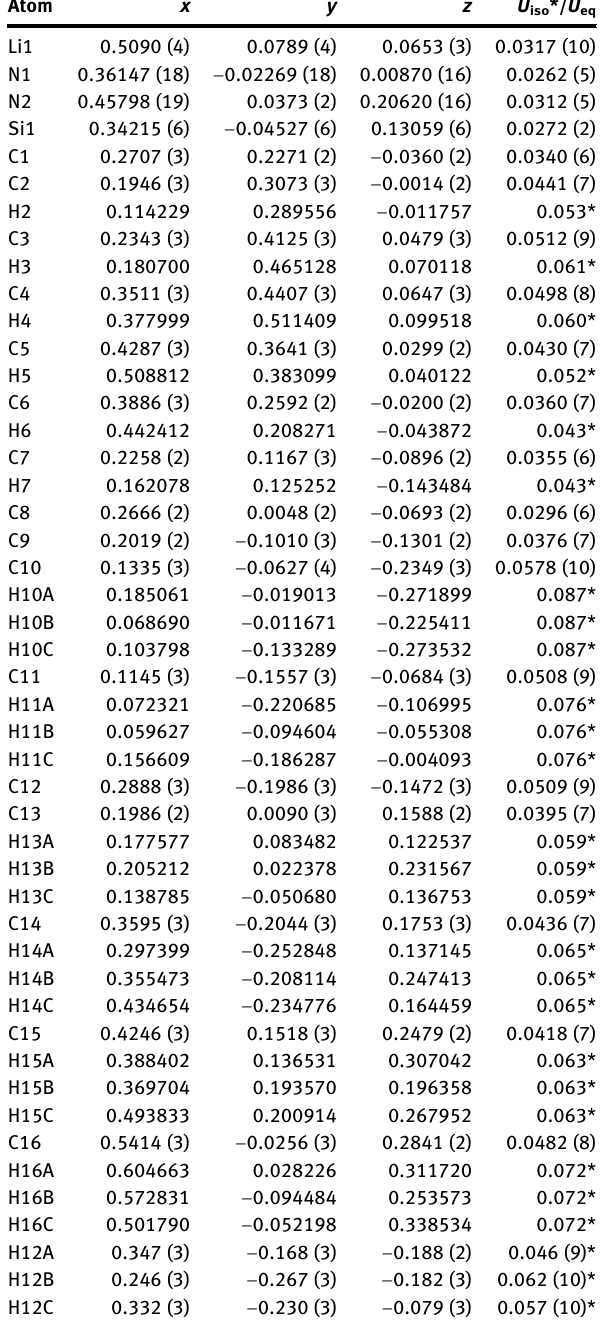
Table  : Fractional atomic coordinates and isotropic or equivalent isotropic displacement parameters (Å 